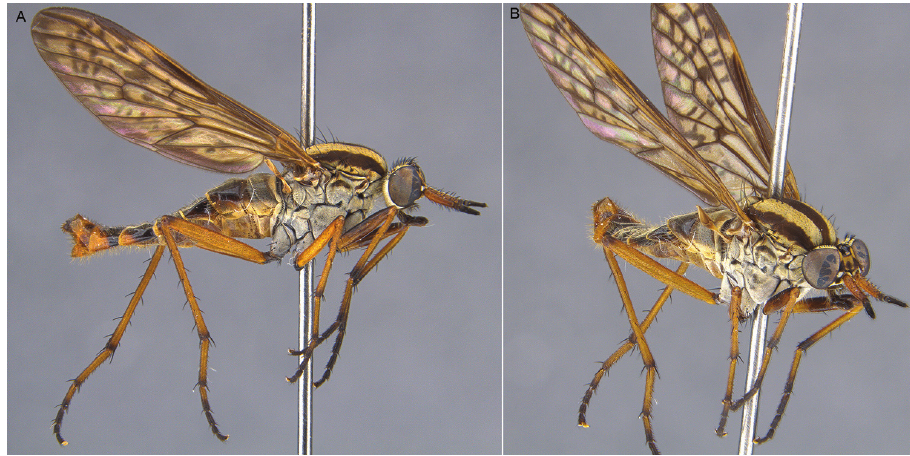
Figure 22. Zelothrix warrumbungles sp. n.: A Female lateral view B same, oblique view. concave with a single row of black postocular setae dorsally in male, two rows in female; gena silver pubescent admixed with pale setae; parafacial silver in male, silver and matte black in female; palpus narrow, pointed apically, with brown with black setae;. Antennal scape elongate and cylindrical, orange, with erect black setae on all surfaces, slightly thinker than flagellum and length equalling length of combined pedicel and flagellum; flagellum elongate and cylindrical, brown pubescent with dis- tinct angled arista at apex. Thorax . Scutum and scutellum gold-silver pubescent, scutum with three distinct dark brown stripes, medial stripe extending onto scutel- lum; chaetotaxy: np, 4; sa, 2; pa, 1; dc, 3; sc, 2; pleuron base colour black, overlain with dense greenish-silver pubescence extending onto coxae; thin white hairs on anepisternum and katatergite; femora bright yellow, forefemur mostly with